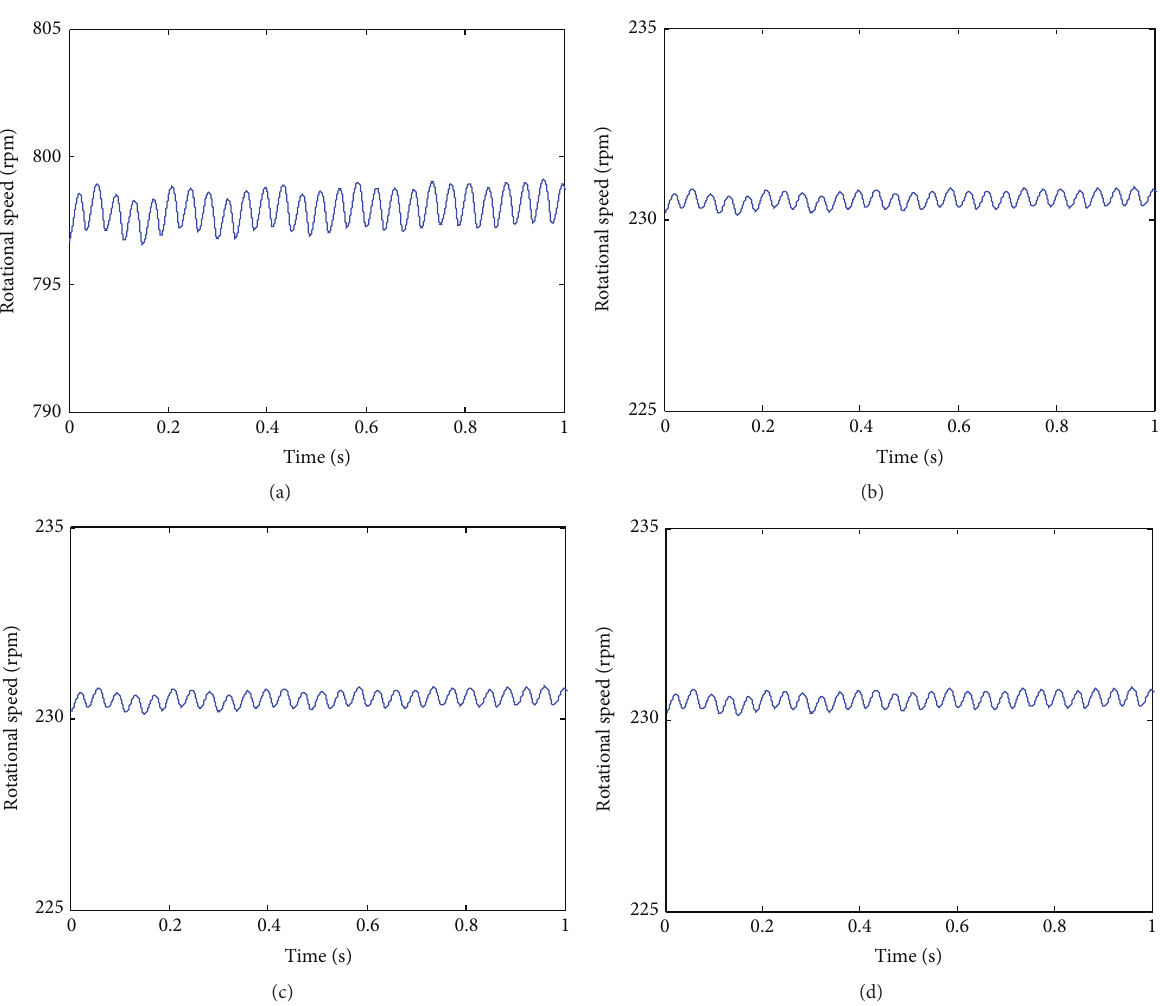
Figure 39: Pinion gear speed of unloaded gear pairs after optimization: (a) the 2nd gear pair, (b) the 3rd gear pair, (c) the 4th gear pair, and (d) the 5th gear